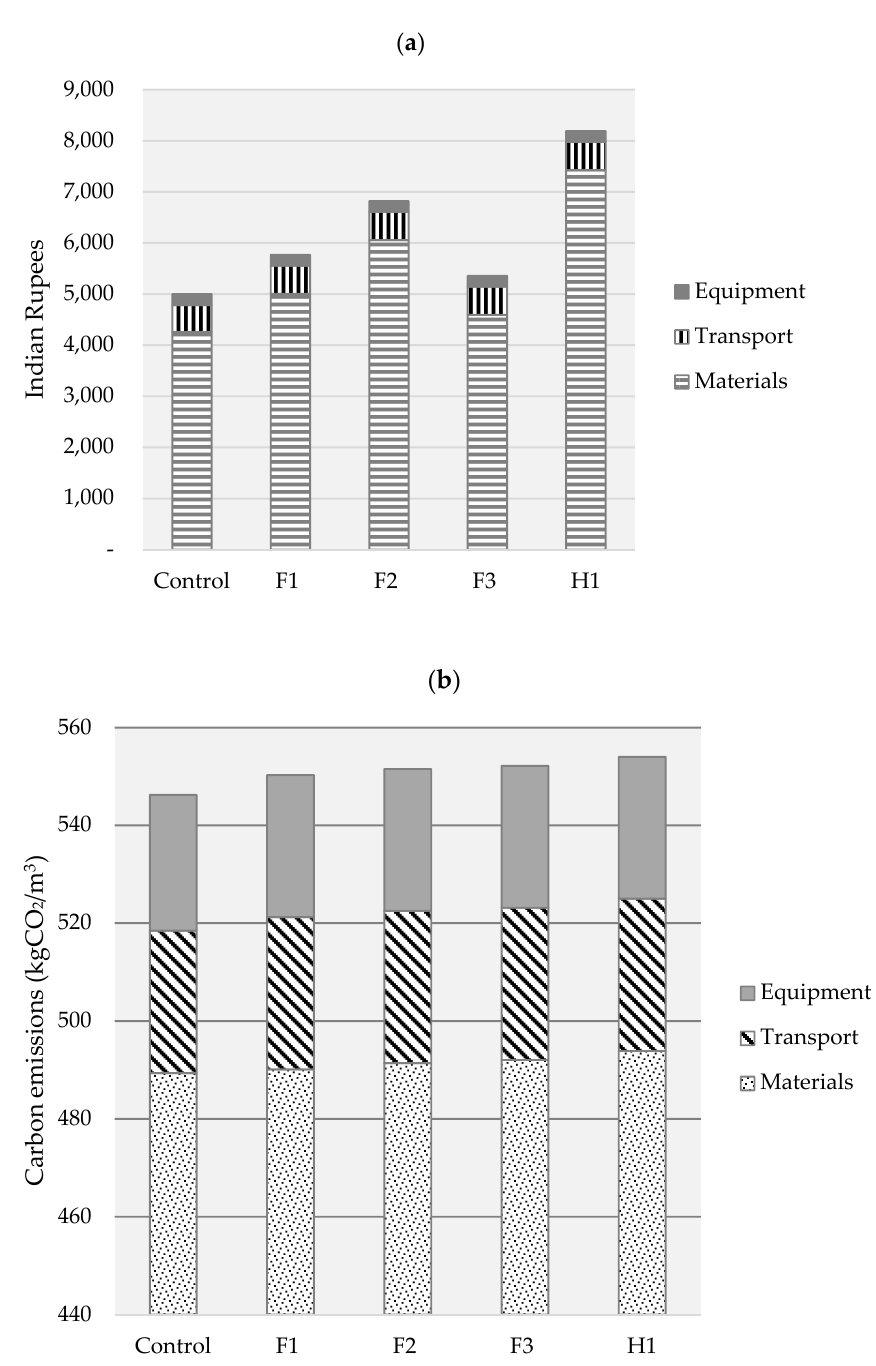
Figure 7. Manufacturing cost and carbon emissions of different mix designs. ( a ) Cost per m 3 of sample (INR). ( b ) Carbon emissions per m 3 of sample (kgCO 2 )